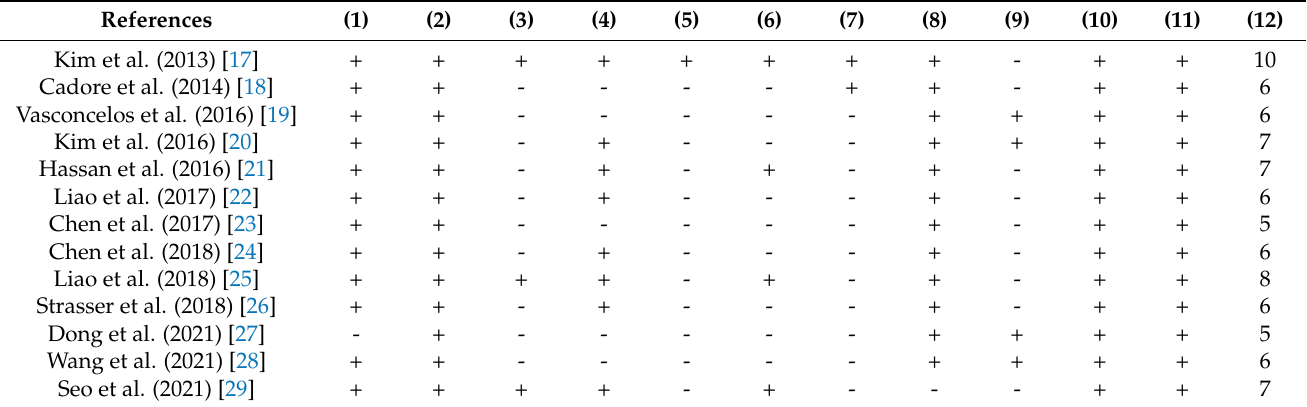
Table 2. Physiotherapy Evidence Database (PEDro) score of the included studies.